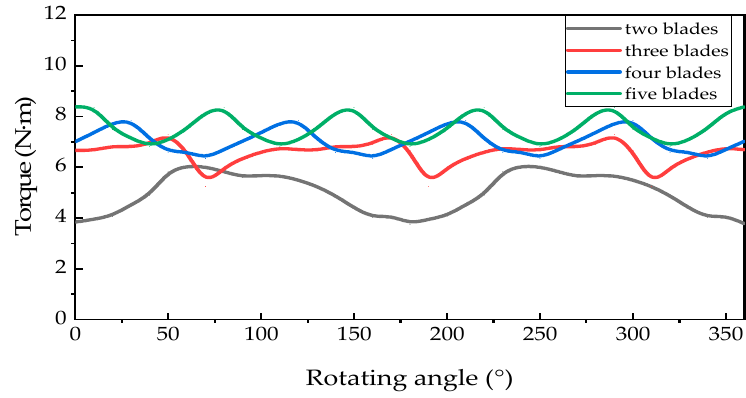
Figure 11. Torque comparison curve when the number of blades is two, three, four and five.